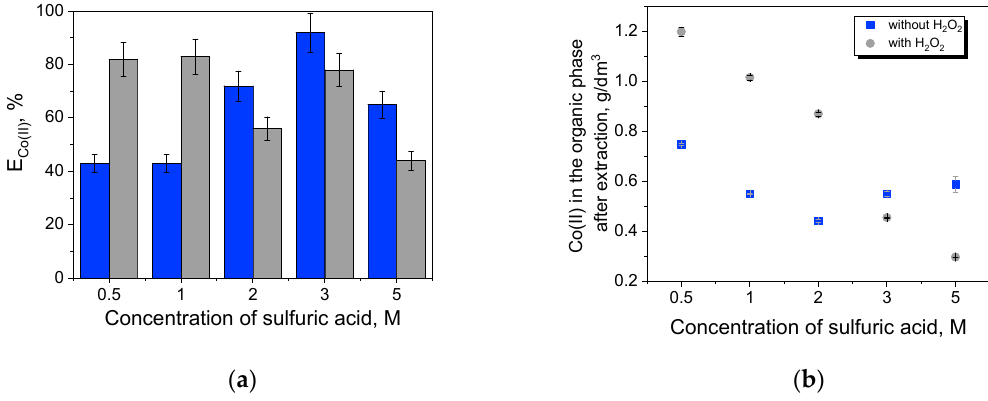
Figure 6. Dependence of ( a ) percentage extraction of Co(II), ( b ) concentration of Co(II) in the organic phase after extraction from solutions after leaching with ( (cid:4) ) sulfuric acid or ( (cid:4) ) sulfuric acid with H 2 O 2 addition.